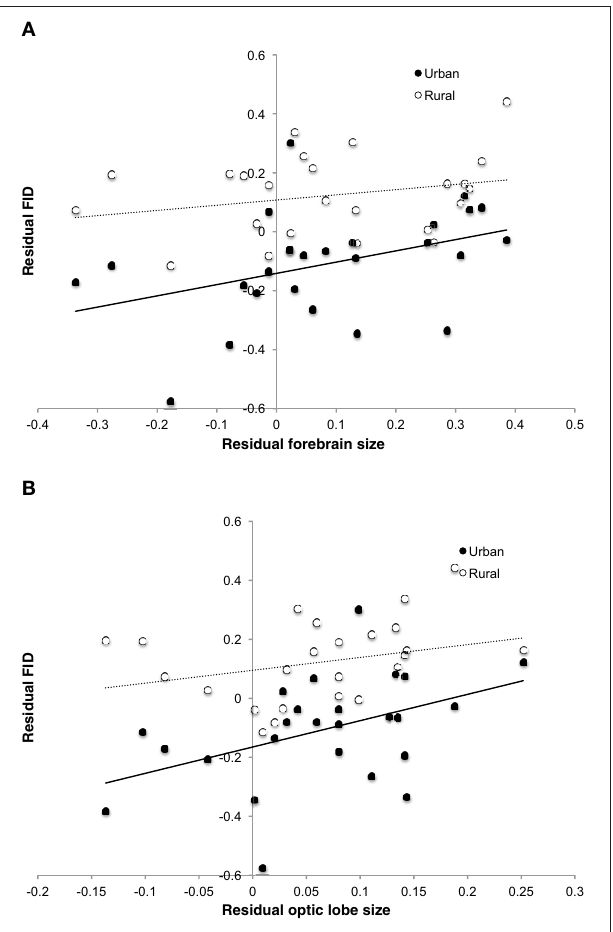
FIGURE 5 | Relationship between FID and (A) forebrain size and (B) optic lobe size in both rural and urban populations of 25 bird species. While rural populations, and species with greater brain component masses, have longer FIDs, there is no difference between populations in the relationship of brain component sizes to FID. FID values are the residuals from the regression of absolute log FID against log body mass and log starting distance. Brain size values are the residuals of the log transformed trait mass against log body